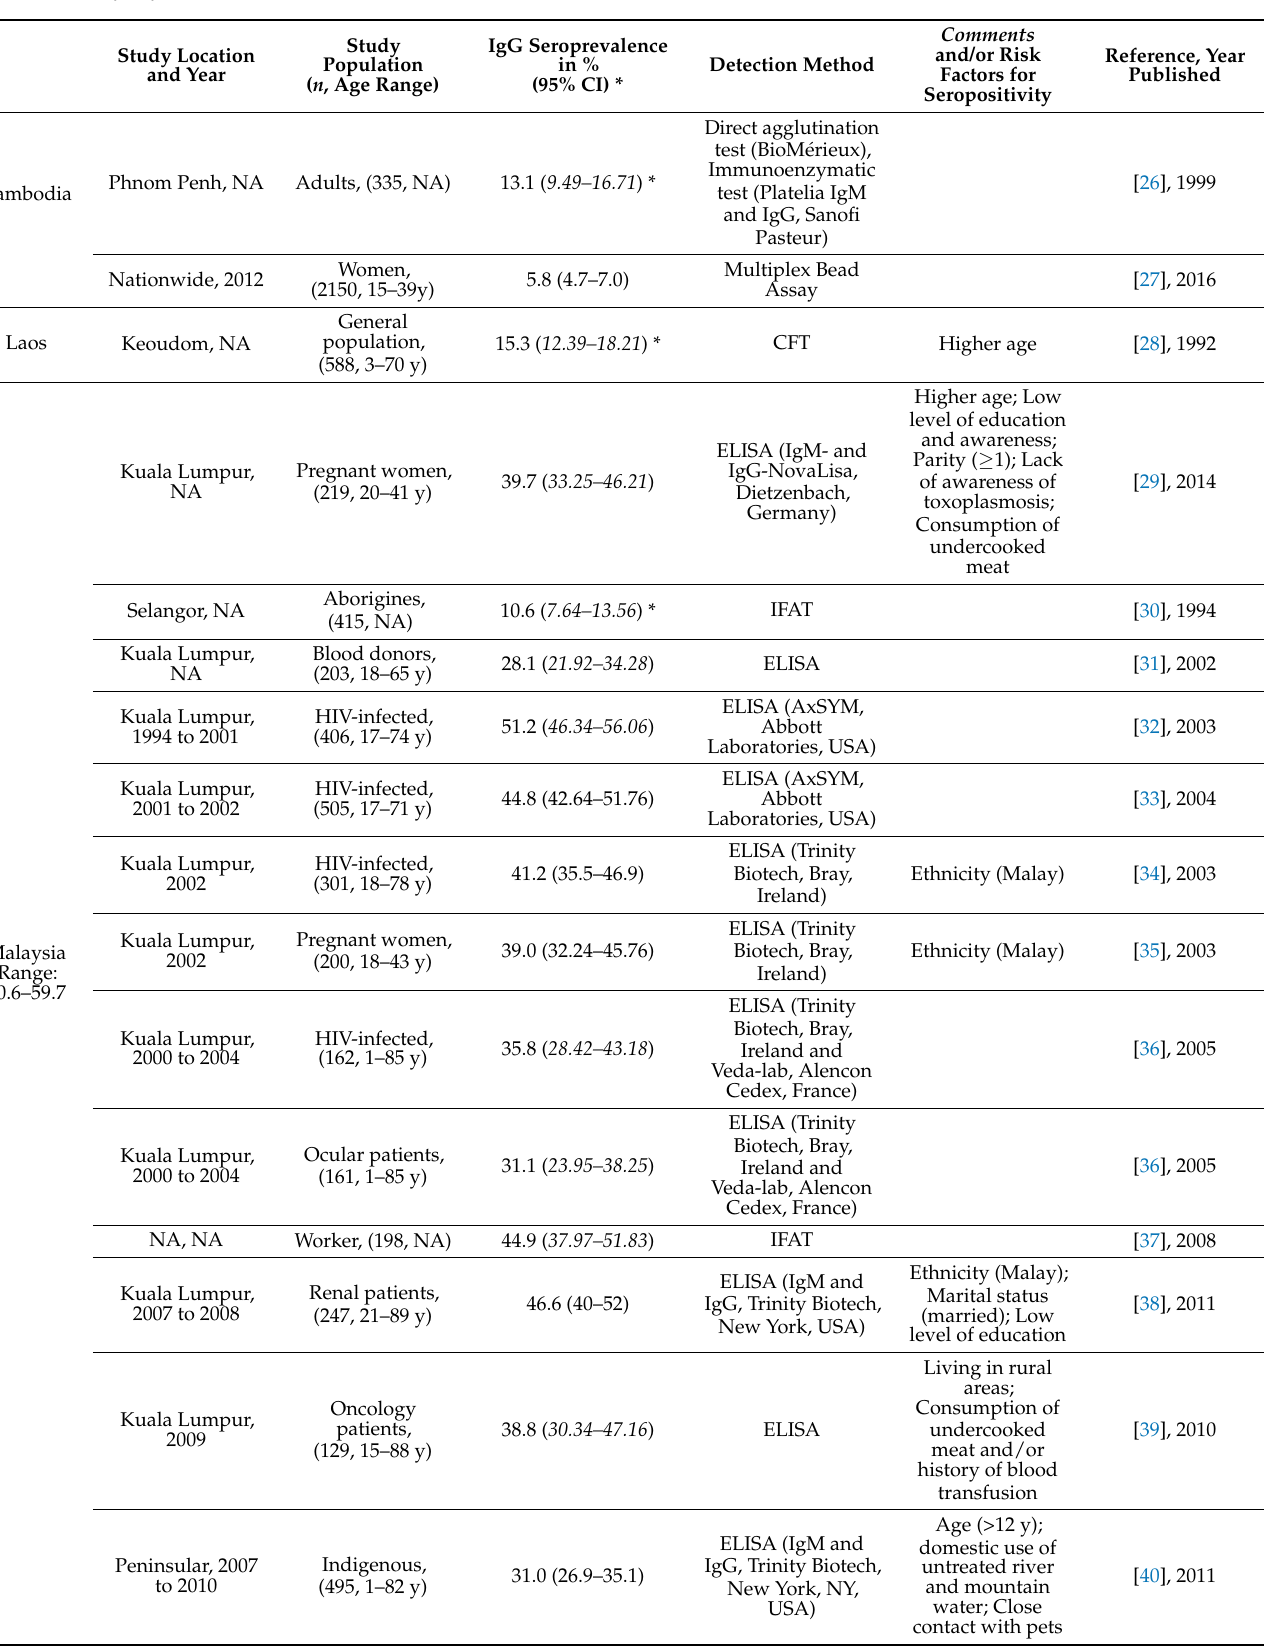
Table 2. Toxoplasma gondii IgG serosurveys. * Only results on overall antibody seroprevalence (IgM + IgG) are available; Confidence Intervals (CI) in Italics are estimated as described in the Methods; CFT = Complement fixation test; ELISA = Enzyme-linked Immunosorbent Assay; IFAT = Immunofluorescent antibody test; LAT = Latex agglutination test; NA = not available; y =